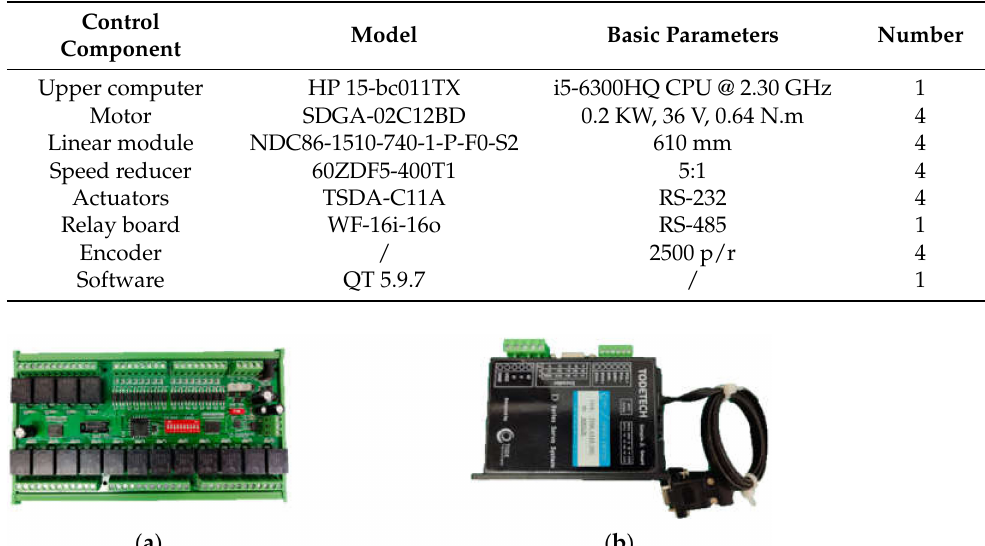
Table 2. Main technical aspects of the LOBO.